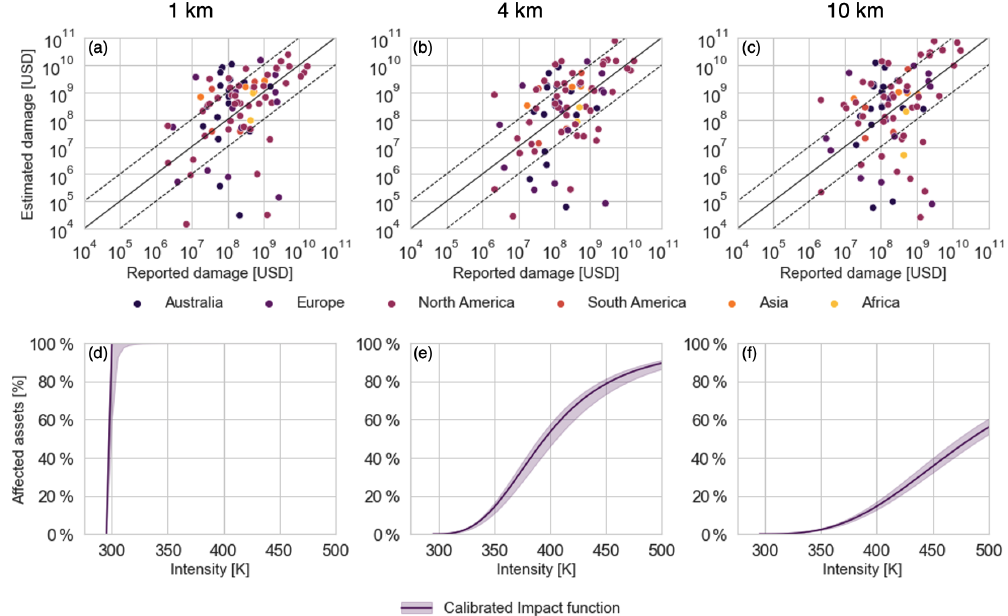
Figure 1. (a–c) Reported damages against estimated damages for hazard and exposure resolutions of (a) 1km, (b) 4km, and (c) 10km. The dotted lines indicate a deviation of an order of magnitude from a perfect estimate and colours group events by continent. (d–f) The corresponding calibrated impact functions for the different resolutions (d) 1km, (e) , 4km and (f) 10km, relating satellite-detected fire temperature to percentage damage. The shading indicates uncertainties as assessed using a 10-fold cross-validation of model parameter I half